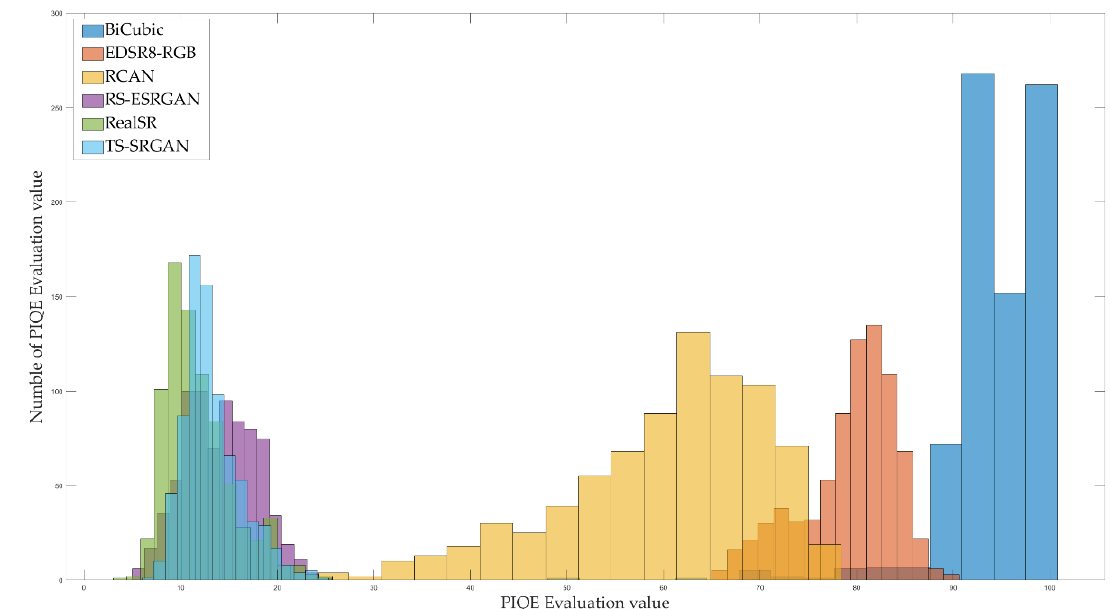
Figure 12. Distribution of evaluation values of NR-IQA metric BRISQUE.